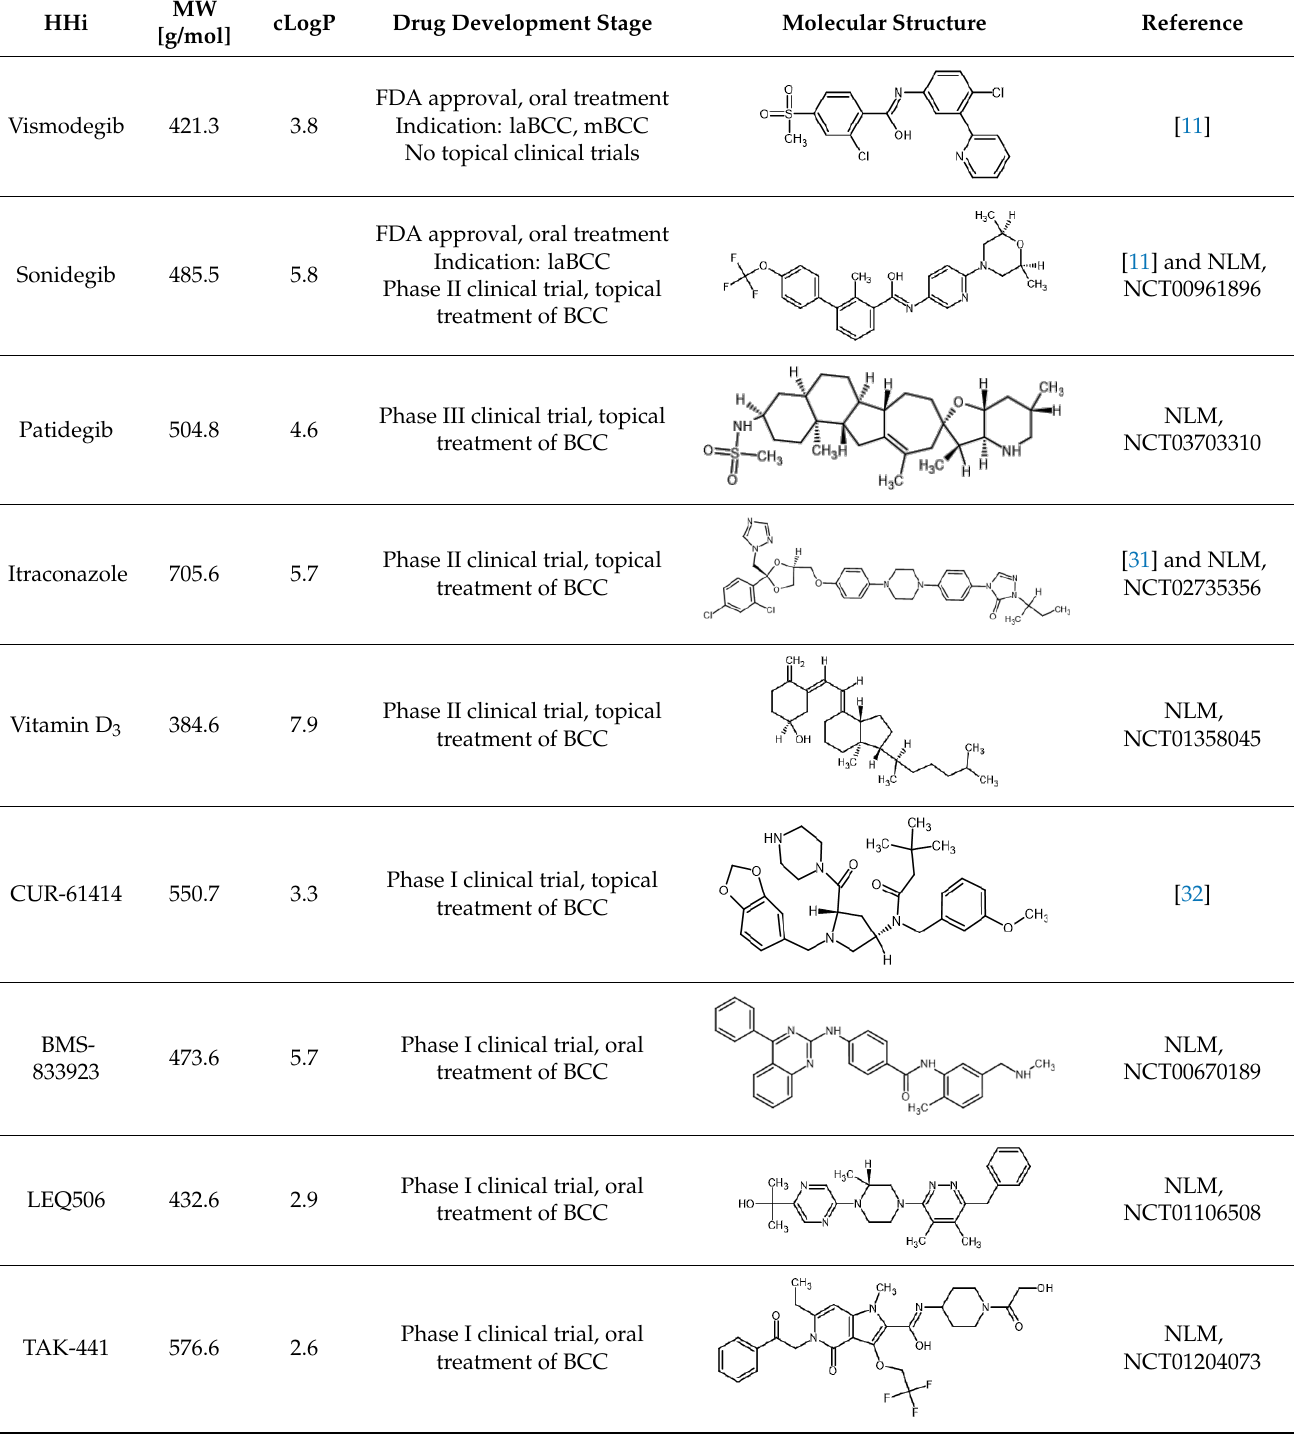
Table 2. HHi drug structures and molecular properties. Information on ZSP1602 and arsenic trioxide was not found. An increased clogP value corresponds to increased